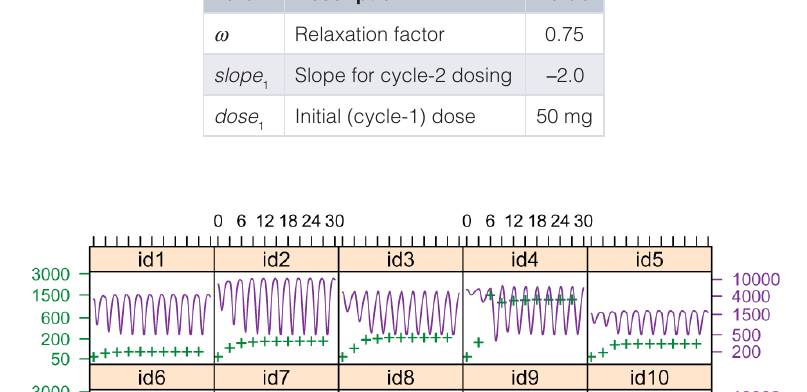
’s evident in this figure span 1.5 orders i